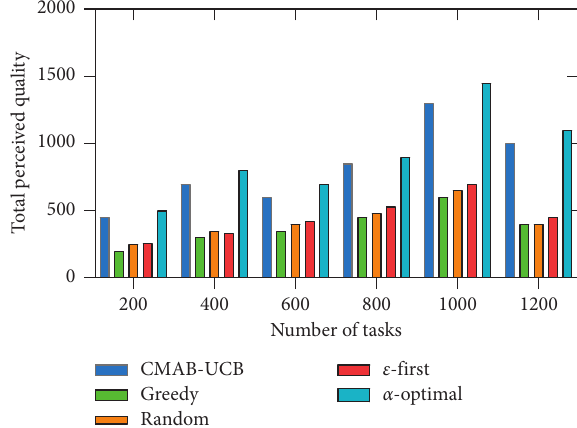
Figure 9: The relationship between perceived quality and the number of posting tasks ( b �